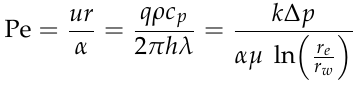
Figure 7. Comparison of system heat transfer at different Peclet numbers: Pe = 1 (blue); Pe = 10 (green); Pe = 20 (red); Pe = 40 (purple).